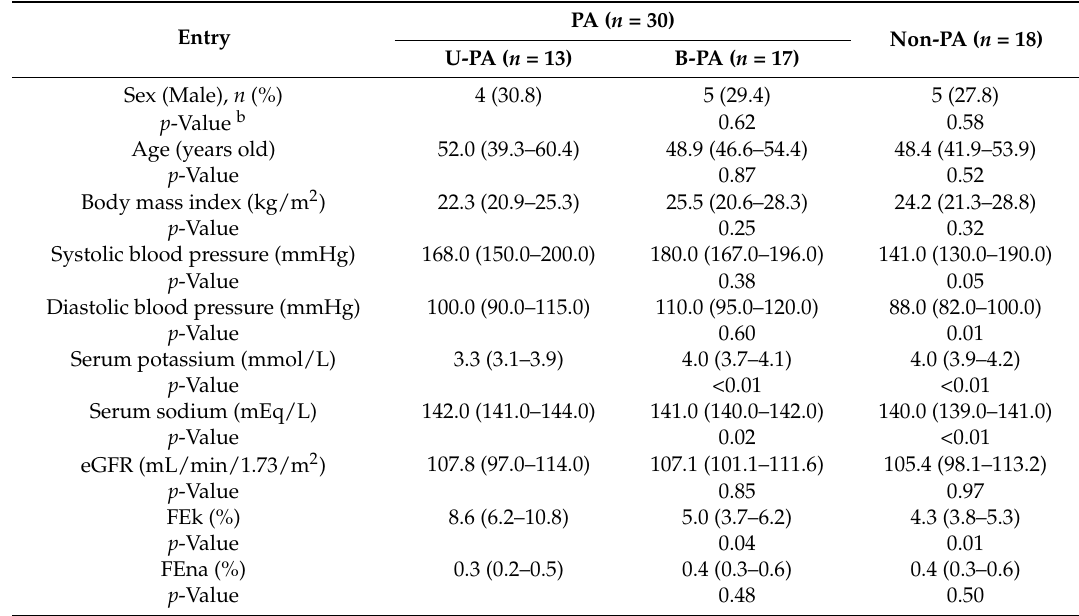
Table 1. Clinical characteristics a